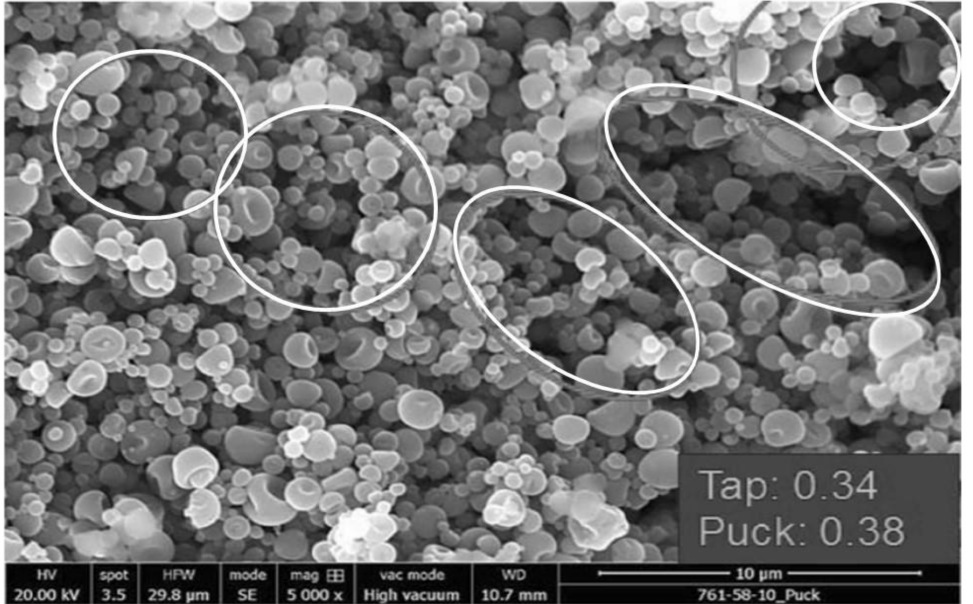
Figure 4. Scanning electron micrograph image of compressed spherical anti-TSLP Fab particles (Lot A7) showing large voids in powder bed